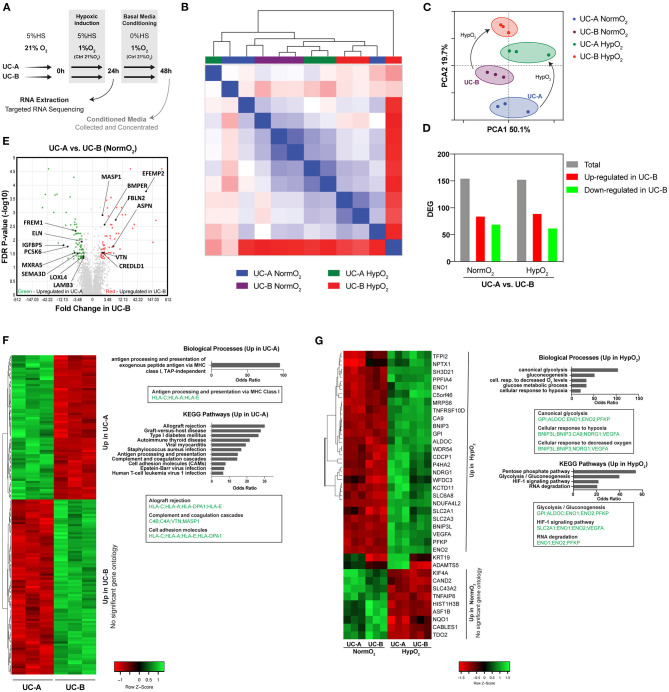
Transcriptomic profiles of UC-A and UC-B in normoxia and in response to hypoxia. (A) Schematic overview of the experiment. (B) Unsupervised hierarchical clustering of RNA-Seq datasets obtained from 3 independent experiments of each conditionUCM-MSC line. (C) Principal component analysis (PCA) of the 12 RNA-Seq datasets showing an overlap on PCA1 and clustering on PCA2. (D) Number of total differentially expressed genes (DEG) and of genes up- and down- regulated in UC-B compared to UC-A, under normoxia and hypoxia conditions (fold-change>±2, FDR < 0.05). (E) Volcano Plot of the DEG highlighting the statistically significant matrissome-associated genes. (F) Heatmap hierarchically organized by combined ranked score of DEG in normoxia conditions alongside the corresponding GO and KEGG pathways enrichment analysis. (G) Analysis of the DEG in normoxia vs. hypoxia for each UCM-MSC donor. Heatmap hierarchically organized by combined ranked score of the common DEG altered in the two donors in response to hypoxia; enriched GO and KEGG pathways are plotted.